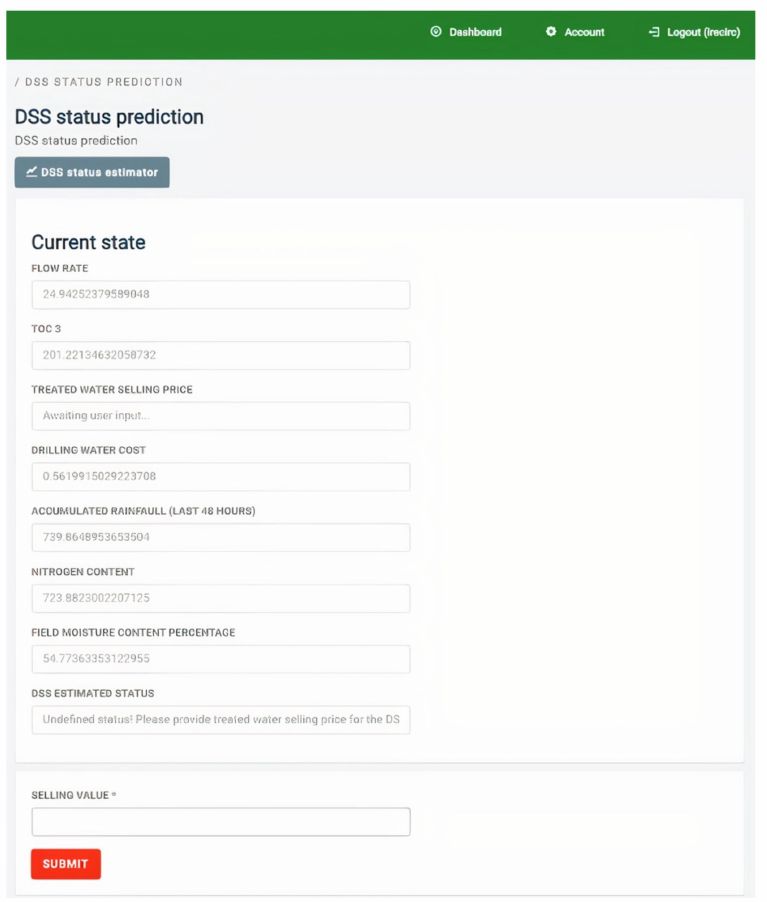
Figure 4. Water quality prediction module. Values are given by end user or collected by the IoT device connected to the water treatment